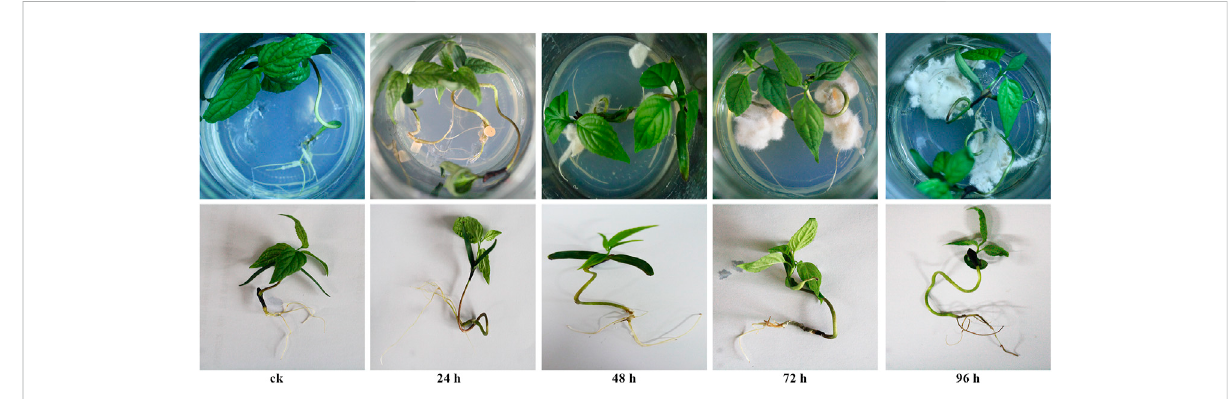
The roots morphology of E. ulmoides seedlings after 0, 24, 48, 72, and 96 h of inoculation with F. oxysporum .